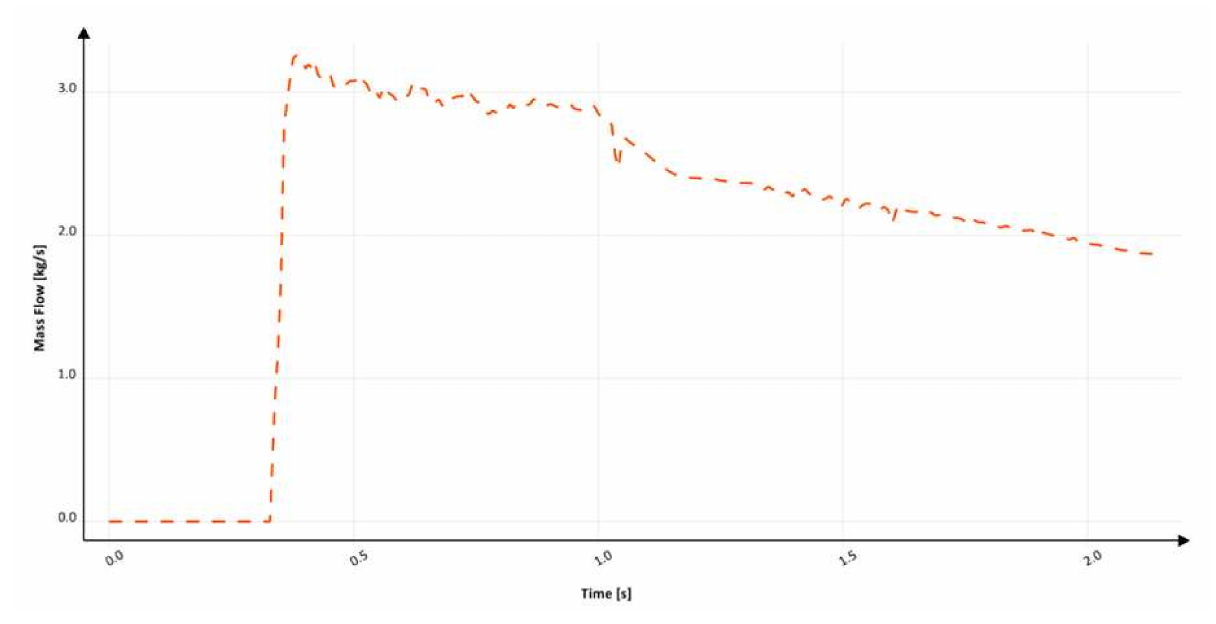
Figure 25. Mass flow through ingate with round, non-tapered with well (S s 4), MAGMASOFT. The fifth design (S s 5) is the first to utilize a positive tapering angle that minimizes the amount of air surrounding the flowing stream. The kinetics of the flow for this variant is presented in Figure 26. An improvement in comparison to the versions shown earlier is clearly visible. Straight-line tapering does not completely eradicate the air pockets; however, it manages to minimize their volume. The falling stream is not in contact with air over the entire length of the sprue, but only a part up to 70 mm from the head of the stream is surrounded by veins of air. At 197.6 ms, when the stream reaches the bend, a large bubble is formed. Complete pressurization of the sprue is achieved after 215.6 ms, and that of the runner occurs after 369.6 ms. This design also presents a cavitation void near the ingate. In contrast to the previous designs, due to the presence of the tapering, which increases the friction during the flow, the velocity of the falling stream does not exceed 3.5 m/s in the sprue; however, the maximum value is close to 3.5 m/s. However, after passing the first bend, centrifugal force compacts the stream, which for a short time exceeds 3.5 m/s. This issue is connected to decreased turbulence at the bottom of the sprue, which consumes a portion of energy, resulting in a decrease in velocity. Additionally, the tapering angle results in a decreased surface area at the bottom of the sprue, which, after pressurization in accordance with the stream continuity law, must present higher velocity. One may think that the designs shown might be better due to the possibility of velocity reduction by the presence of an increased volume. Unfortunately, this would not be the right way; it is vital to emphasize that there are relatively easy ways of delivering the stream to the mold cavity with decreased velocity that do not require its reduction through the occurrence of turbulence, which happens if there is excess volume in the